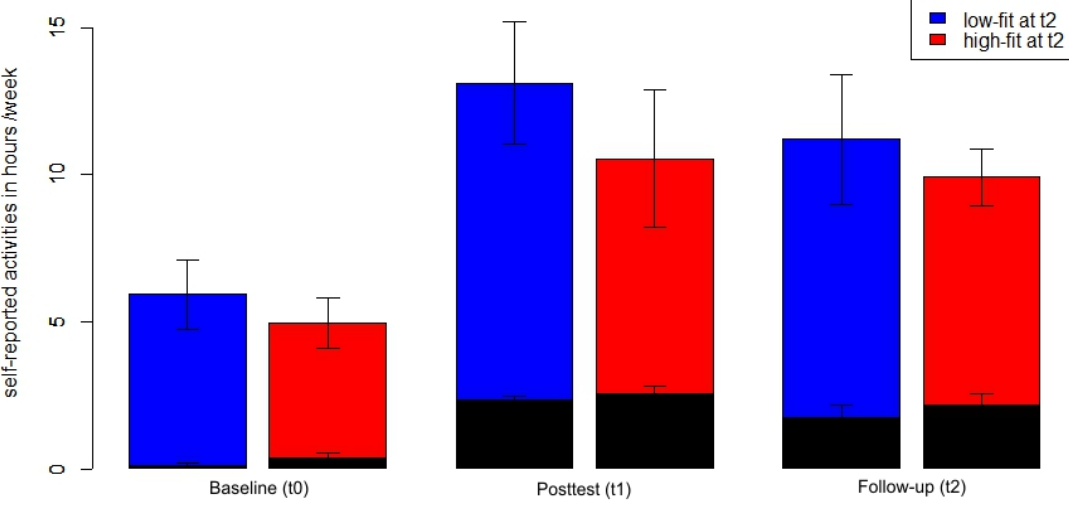
Figure 3. Total physical activity (blue and red bars) and sports activities (black, superimposed bars) in hours per week across time points separately for participants with high fitness (red) vs . low fitness (blue) at t2. Mean with standard error